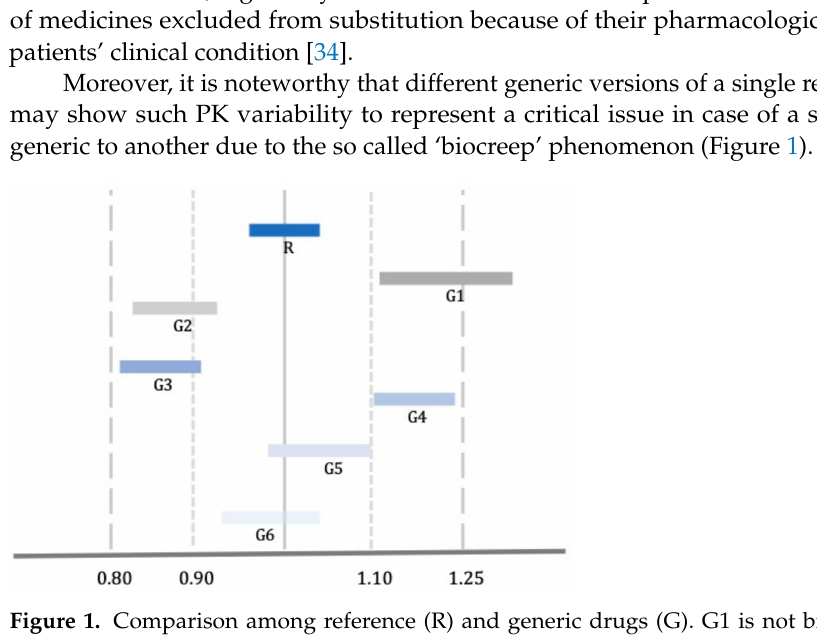
Figure 1. Comparison among reference (R) and generic drugs (G). G1 is not bioequivalent to R according to the standard criteria ( − 20/+25), and G2 is not bioequivalent to R according to the stricter criteria for NTI drugs. G3 and G4 meet the standard criteria of bioequivalence; however, they are not bioequivalent to each other. G5 and G6 meet the criteria of bioequivalence for NTI drugs. For example, two generics are both bioequivalent with the reference product with